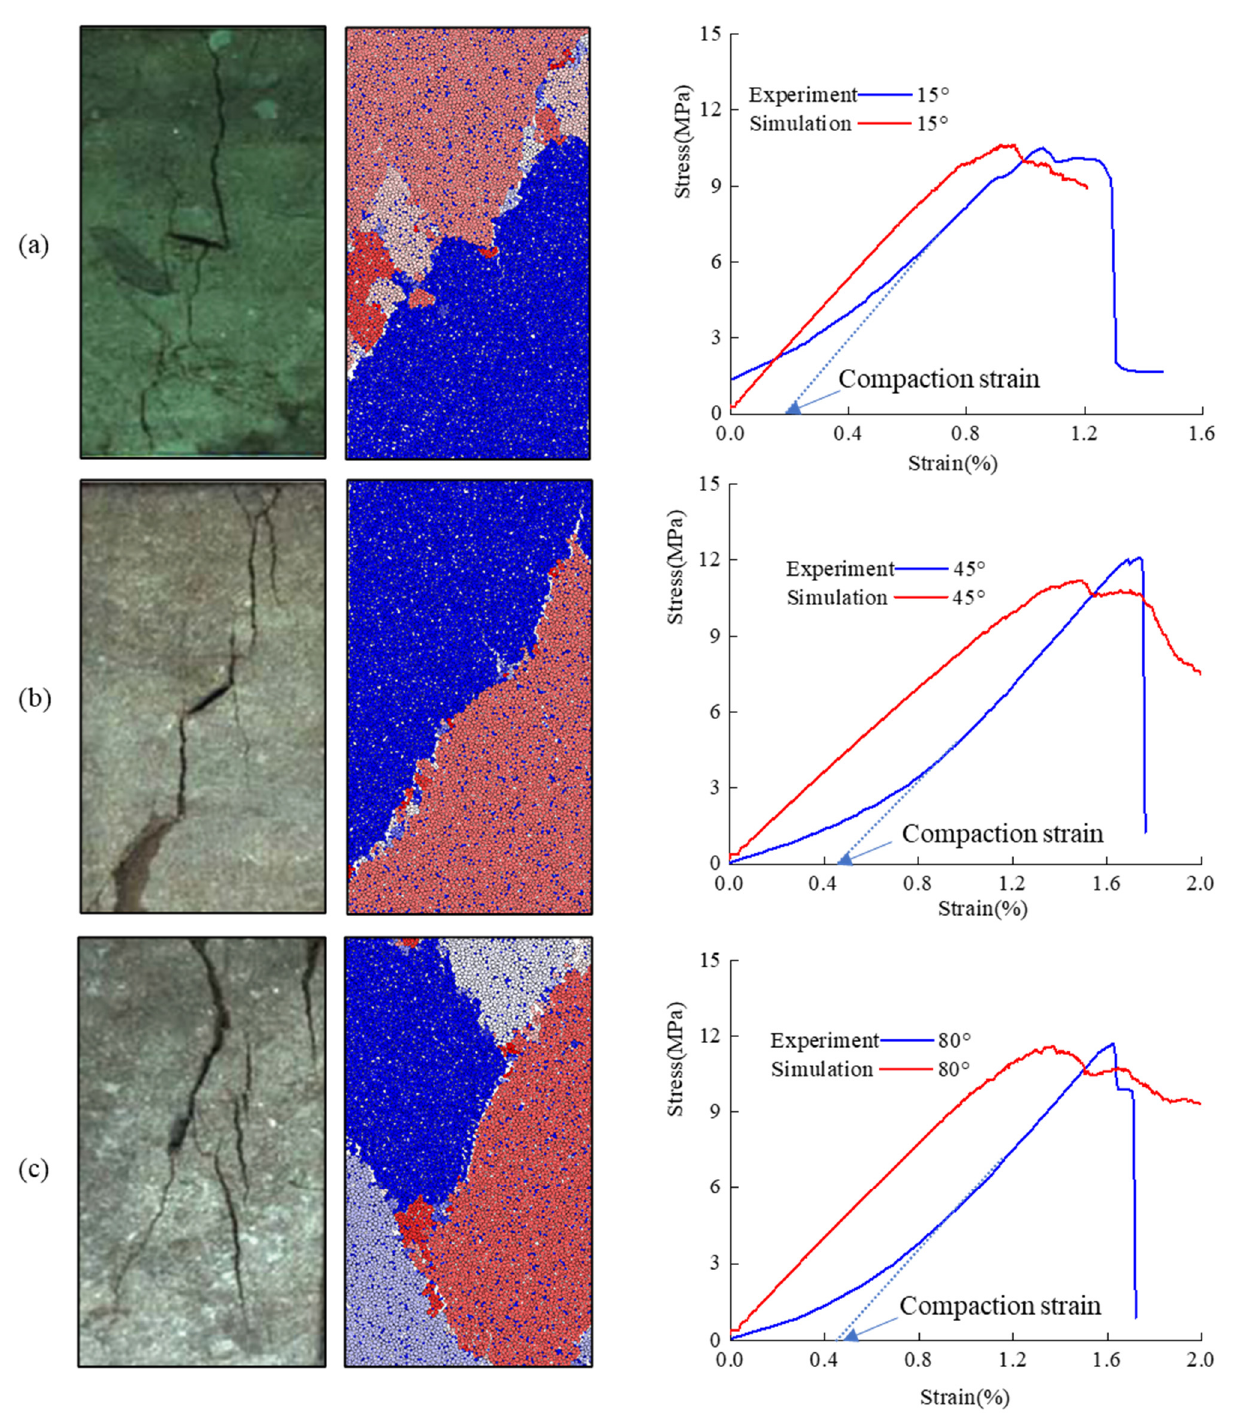
Figure 9. The results of uniaxial loading test with prefabricated cracks. ( a ) 15°; ( b ) 45°; ( c ) 80°.